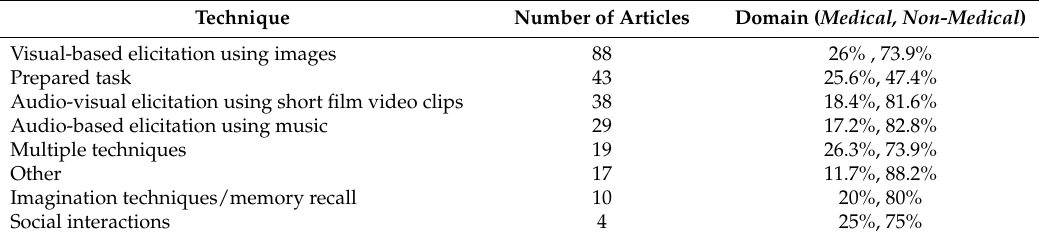
Table 2. Emotion elicitation